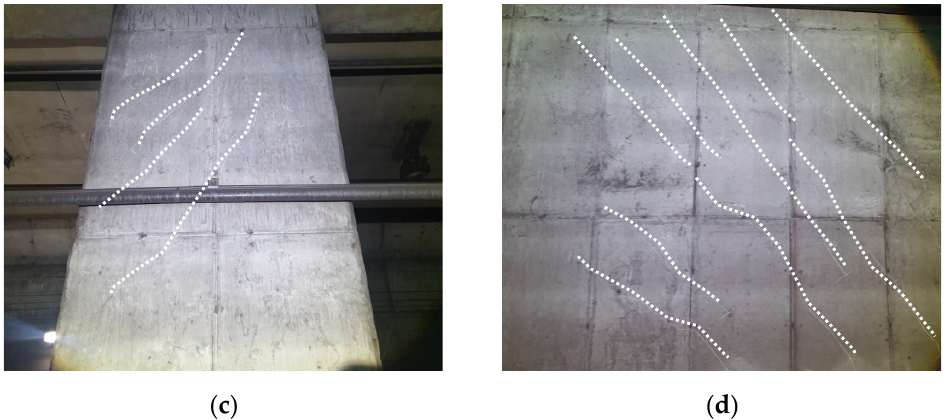
Figure 1. Major damage types: ( a ) wall, transverse crack; ( b ) wall, diagonal crack; ( c ) column, diagonal crack (1); ( d ) column, diagonal crack (2).